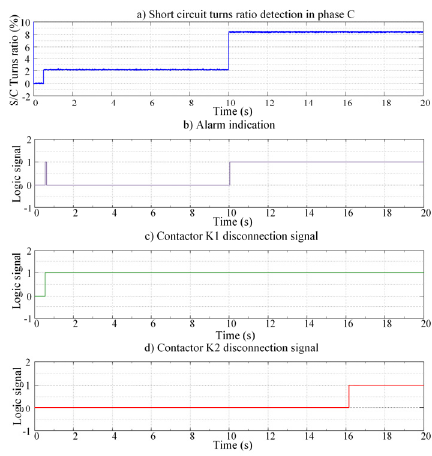
Figure 34. Scenario 2 Alarm indication and contactors disconnection.